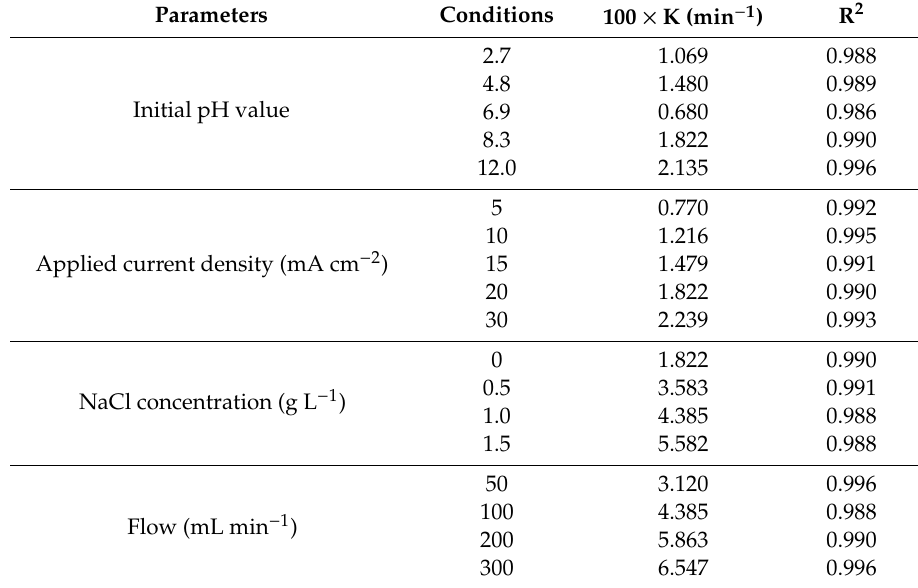
Figure 1. Influence of initial pH value on ammonia removal ( a ), kinetics analysis ( b ), and products distribution ( c ). Applied current density of 20 mA cm − 2 and flow of 100 mL min − 1 . Diluted H 2 SO 4 and NaOH solutions were used for pH adjustments. Table 2. The apparent reaction rate constants of ammonia removal with different initial pH values, applied current densities, NaCl concentrations, and flows.